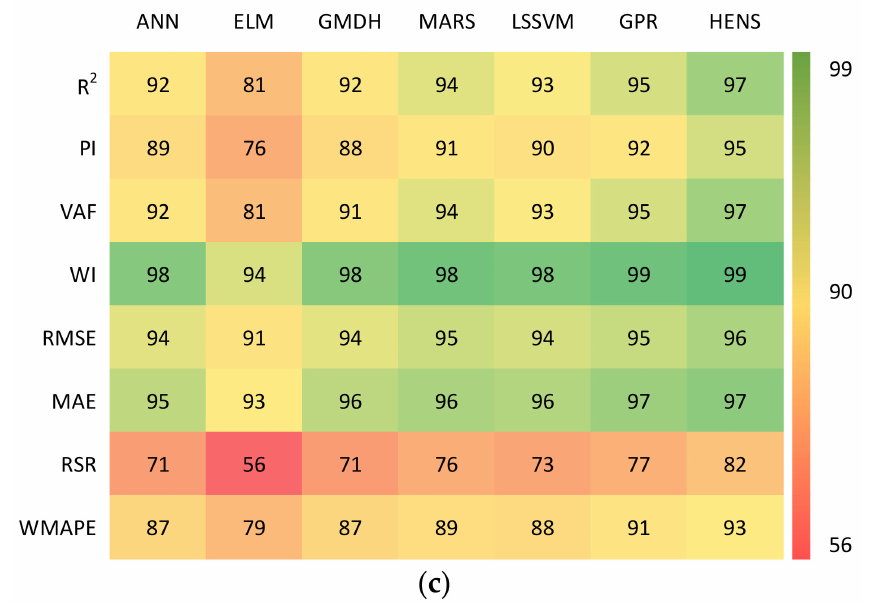
Figure 10. Accuracy matrix for ( a ) training, ( b ) testing, and ( c ) total